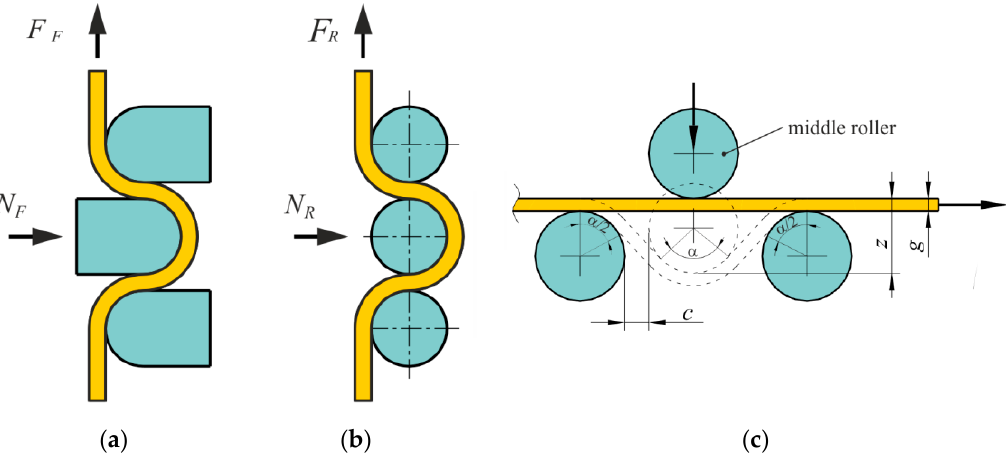
Figure 3 . The concept of determining friction: ( a ) Fixed rollers, ( b ) rotatable rollers, ( c ) geometrical parameters of draw bead.